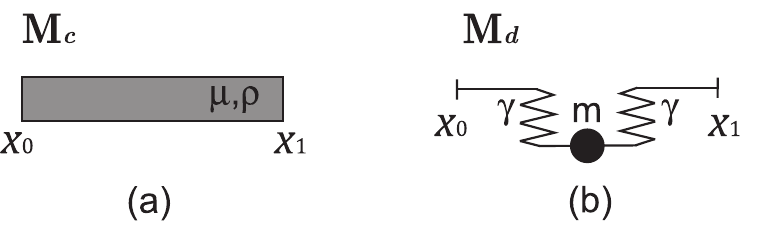
Figure 1. Single units. ( a ) Continuous layer with shear modulus µ and density ρ . ( b ) Discrete unit with mass m and stiffness γ